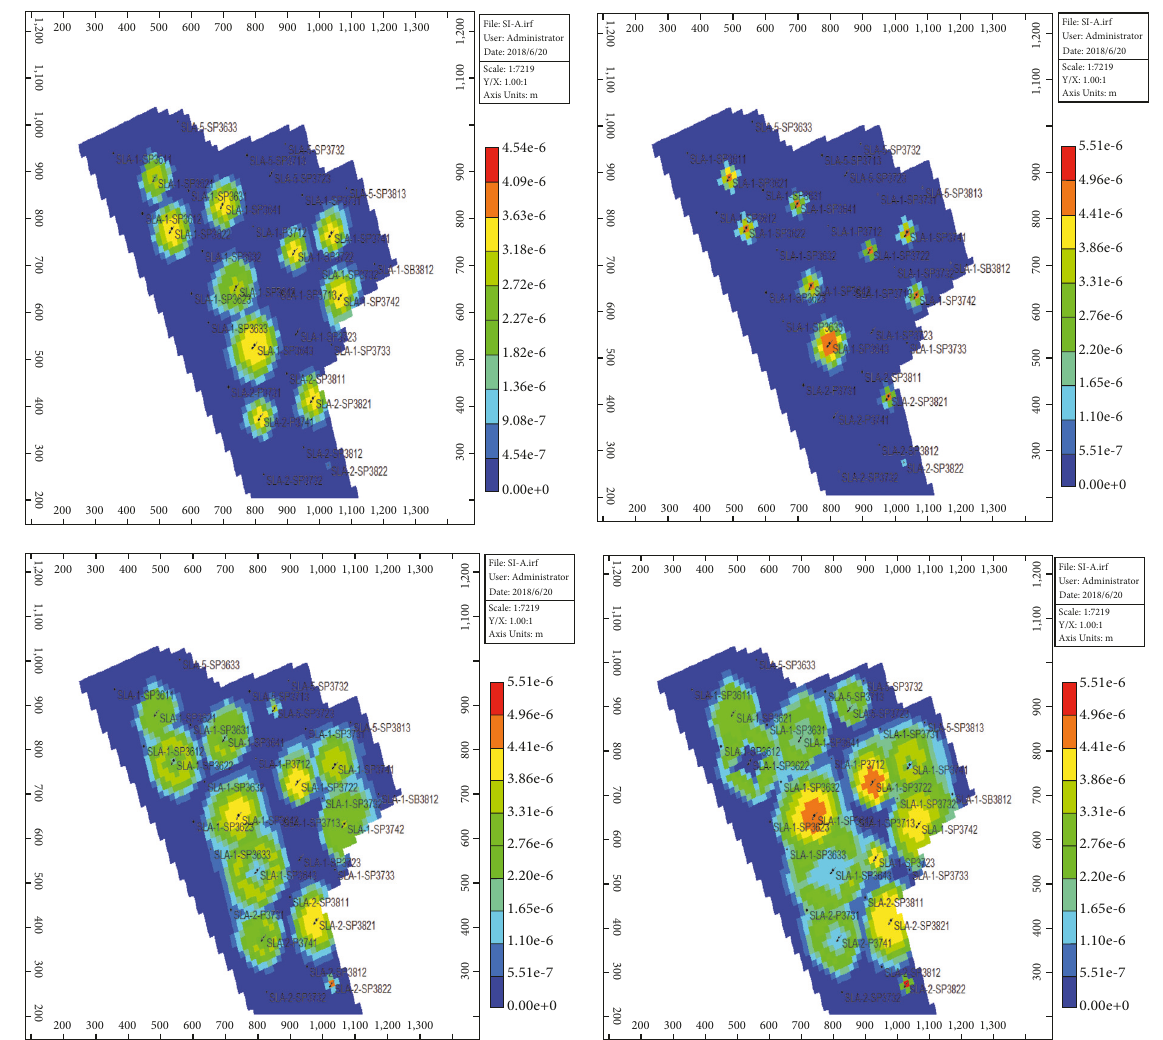
Figure 14: Distribution map of polymer concentration field in SL- Ι layer.